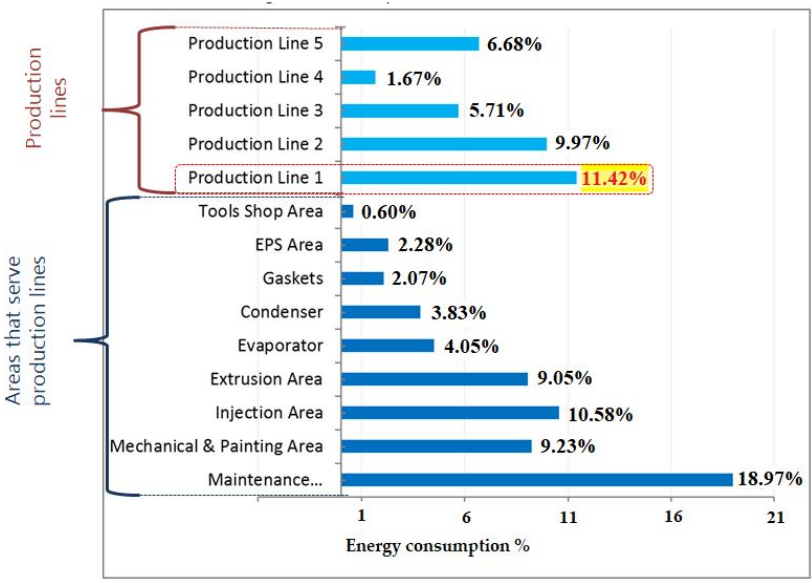
Figure 3. Energy consumption for different areas of the organization.